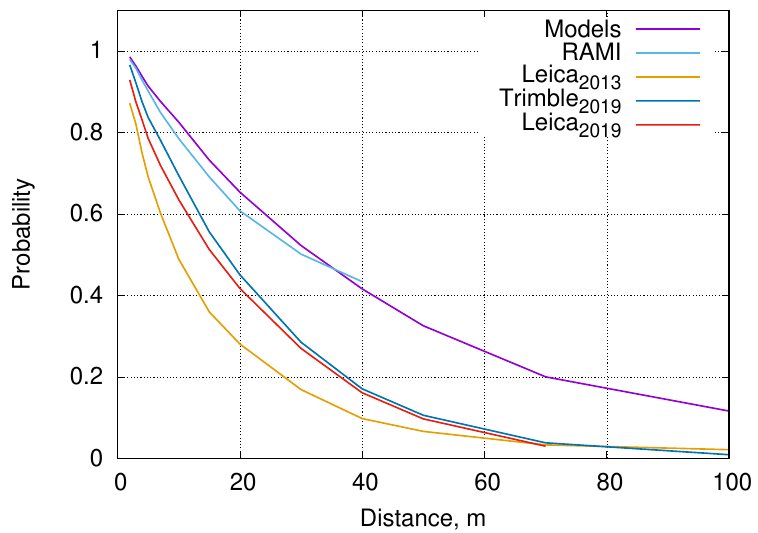
Figure 4. Spruce stand: probability of free line of sight as computed from the generated tree pattern models, as computed from measured tree positions and measured stem diameters (RAMI database), and as estimated from the TLS point clouds generated by three different scanners in three different field